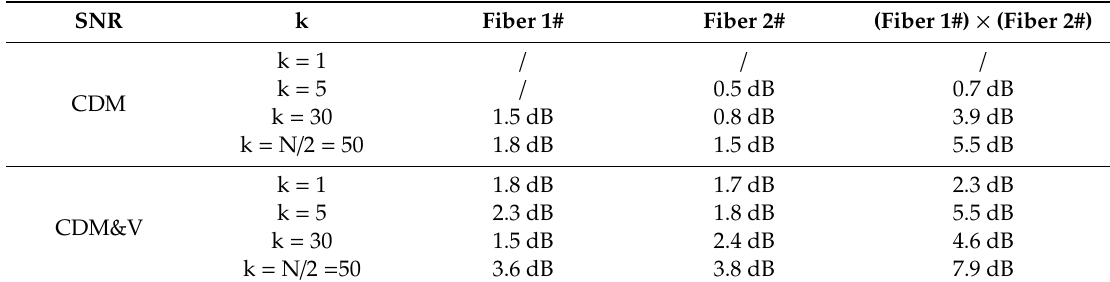
Table 2. Vibration signal comparison between the CDM and CDM&V.